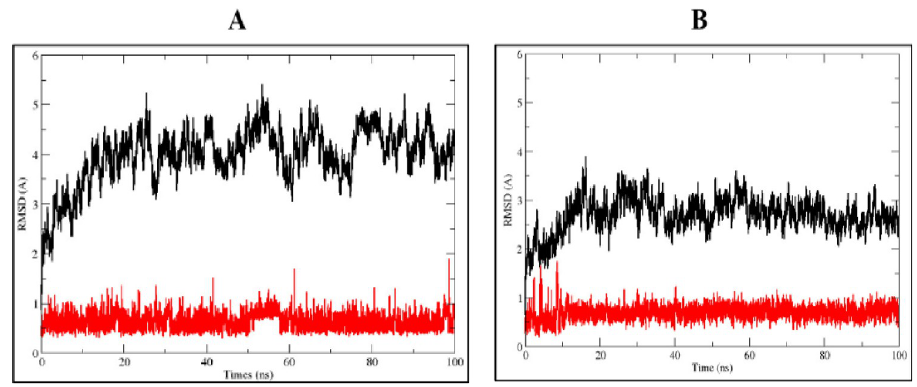
Fig 3. RMSD of active phytoconstituents in complexation with 1R9W: A- Stigmasterol and B-Clicoemodin.